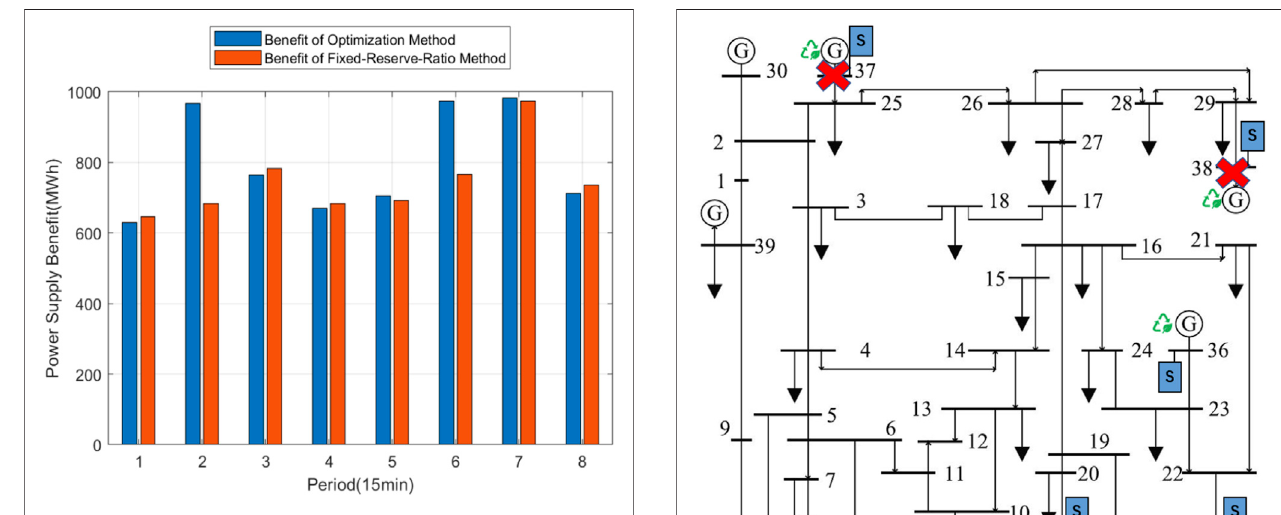
FIGURE 5 | Power supply bene fi ts of the two methods in each period.